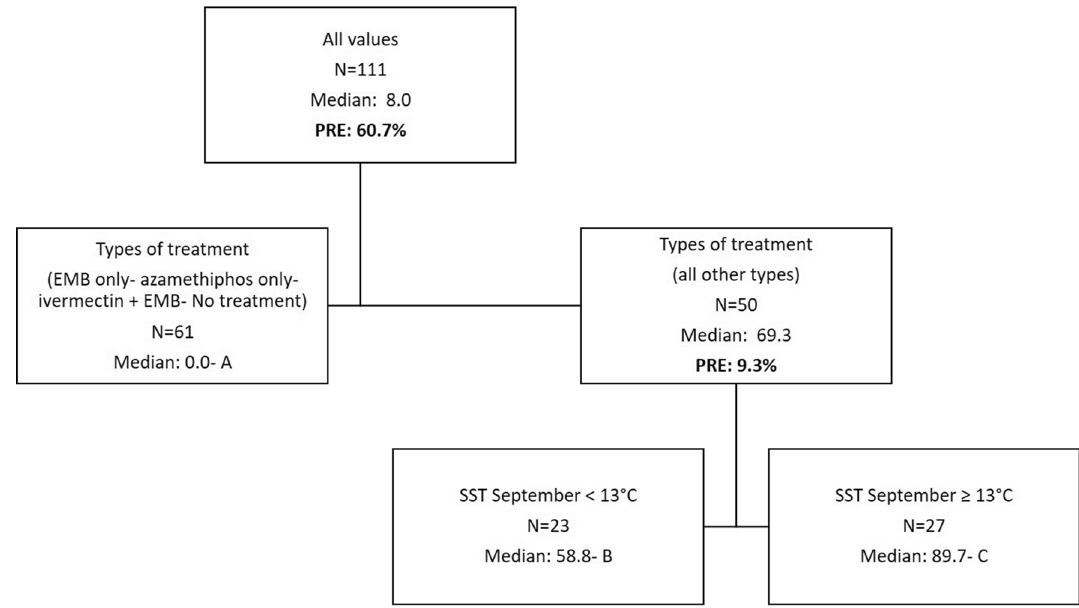
Figure 7. DTA with sums of normalized rates of multi-chemical usage as a dependent variable with a focus on temperature effects. Predictors include: Bay, Company, usage of lumpfish, numbers of fish, types of treatment, stocking year, SST monthly averages (January to December i.e. 12 predictors). The total PRE of this tree is 70.0%.